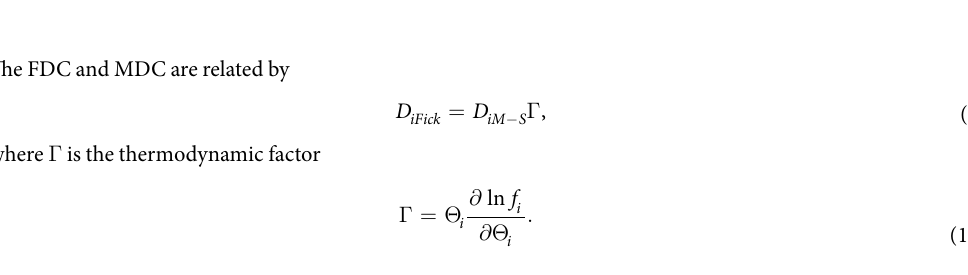
Table 1. Simulation parameters of various simulation systems. Numbers in bracket indicate the corresponding CO 2 or H 2 O concentration in